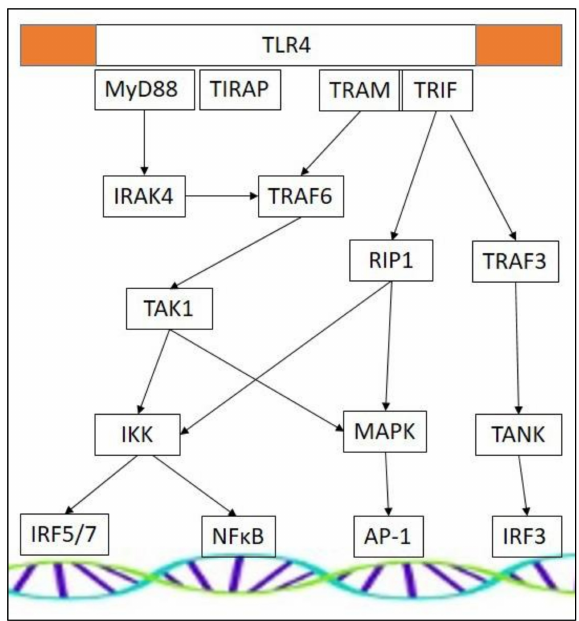
Figure 1. Signaling routes downstream of TLR4. Abbreviations: Activator protein-1 (AP-1), inhibitor of κ B kinase (IKK), interleukin-1 receptor-associated kinase (IRAK), interferon regulatory factor (IRF), mitogen activated protein kinase (MAPK), myeloid di ff erentiation primary response 88 (MyD88), nuclear factor κ B (NF κ B), receptor-interacting protein (RIP), Transforming growth factor- β -activating kinase (TAK), tumor necrosis factor receptor-associated factor (TANK), Toll / IL-1 receptor domain-containing adaptor protein (TIRAP), Toll-like receptor (TLR), tumor necrosis factor receptor-associated factor (TRAF), Toll / IL-1 receptor domain-containing adapter protein inducing interferon- β -related adapter molecule (TRAM), Toll / IL-1 receptor domain-containing adapter protein inducing interferon- β